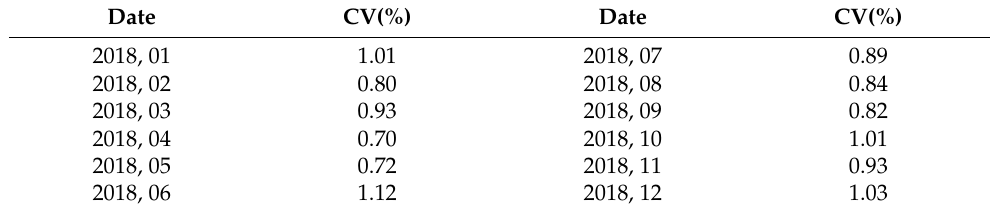
Table 2. CV of the Kufra, Libya field.